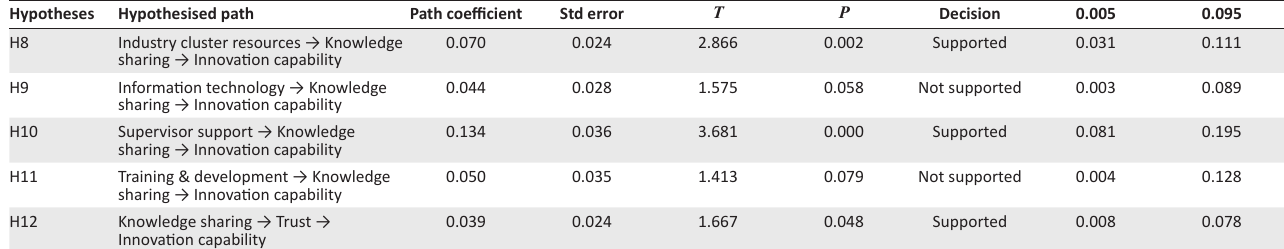
TABLE 6: Mediation test summary. Hypotheses Hypothesised path